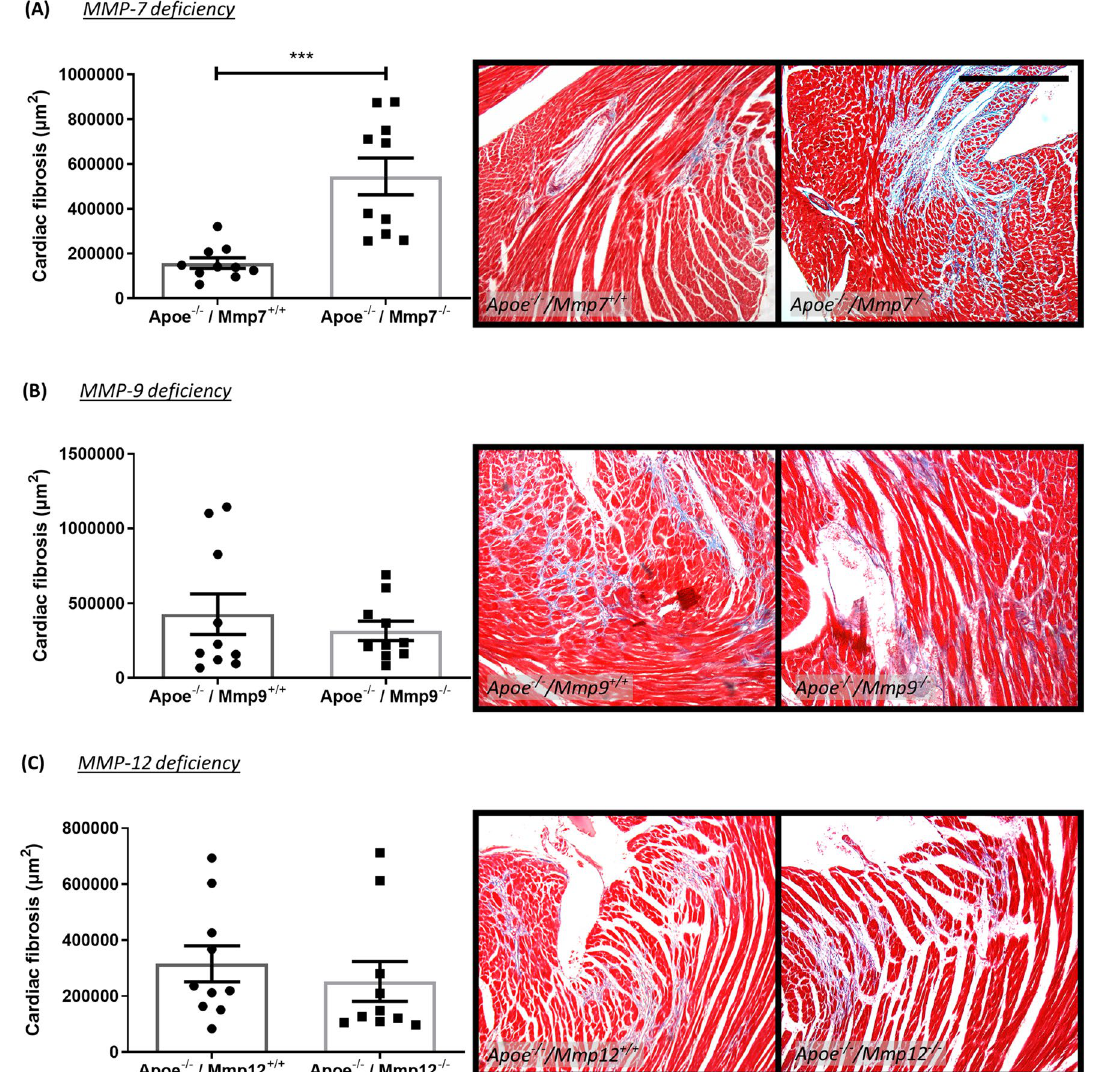
Figure 5. Effect of MMP modulation on cardiac fibrosis in apolipoprotein E-deficient (Apoe -/- ) mice. Quantification and representative images of cardiac fibrosis as assessed in Masson’s trichrome-stained hearts from 36-week high-fat fed Apoe -/- mice deficient for ( A ) MMP-7, ( B ) MMP-9, and ( C ) MMP-12, in comparison to their respective Apoe single knockout controls. Cardiac fibrosis is presented as average fibrillar collagen content (blue) in µm 2 /heart cross-section/mouse. Statistical significance is reported as *** P < 0.001 using unpaired Students t-test. Scale bar represents 1 mm and is applicable to all panels. In all cases, n =